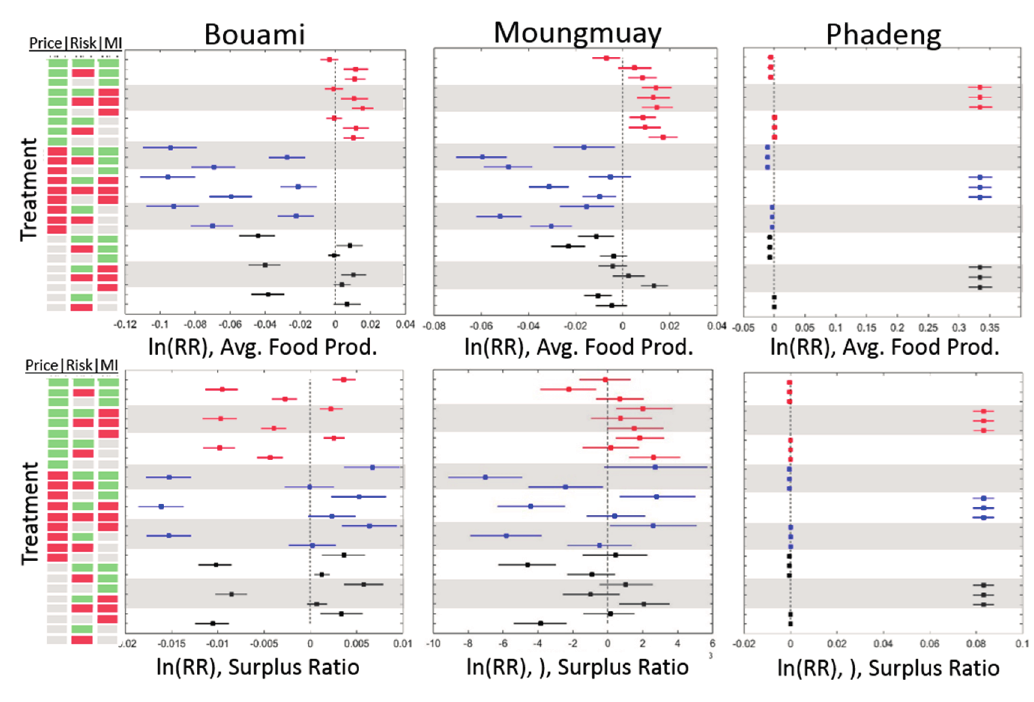
Figure 7. Relationship between mean effect sizes of all experimental treatments on labor allocation evenness ( i.e. , livelihood diversity) and cropland area illustrating non-agricultural responses to experimental treatments in Bouami and Moungmuay relative to mainly agricultural responses in the other